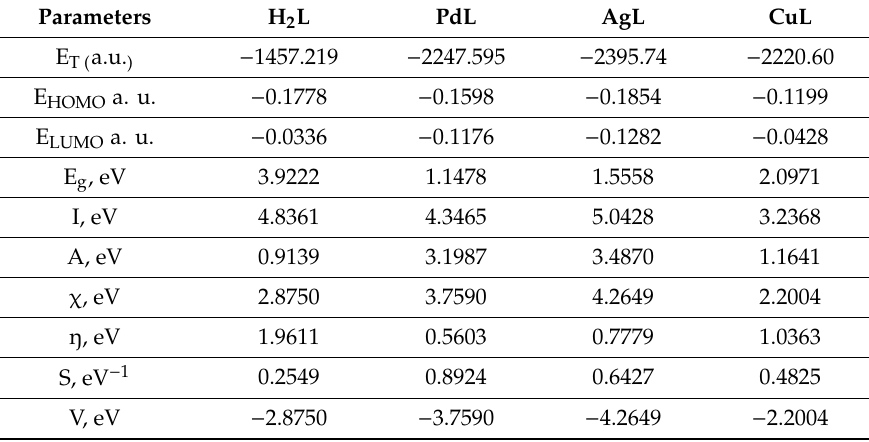
Figure 5. The charge density maps of the highest occupied molecular orbital (HOMO) and lowest unoccupied molecular orbital (LUMO) of studied complexes. Table 4. Quantum and non-quantum global properties of the studied compounds.